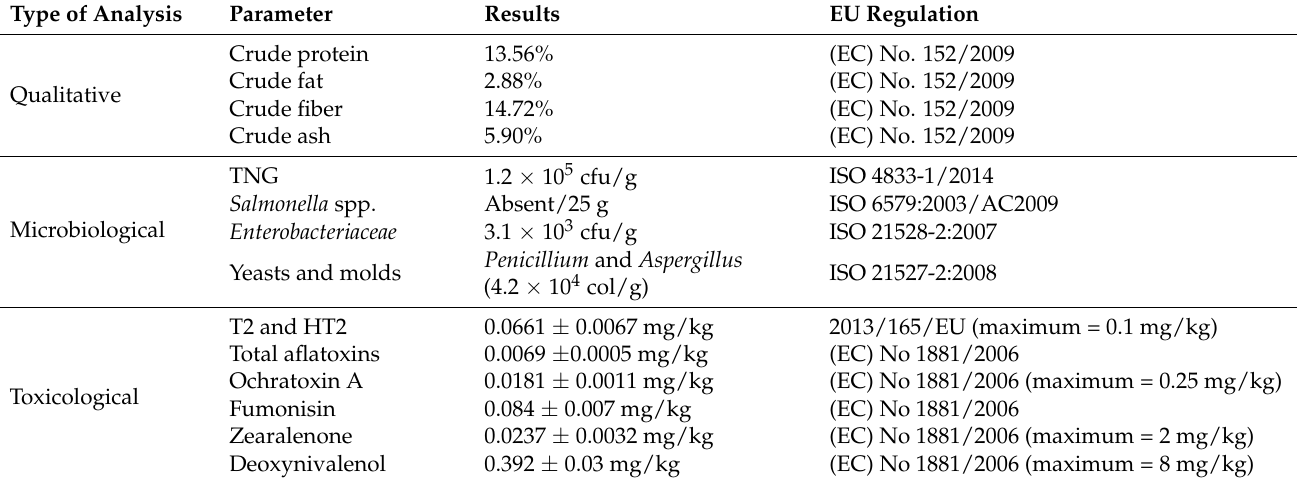
Table 1. Results of qualitative, microbiological, and toxicological analysis of A. annua leaf powder used in the